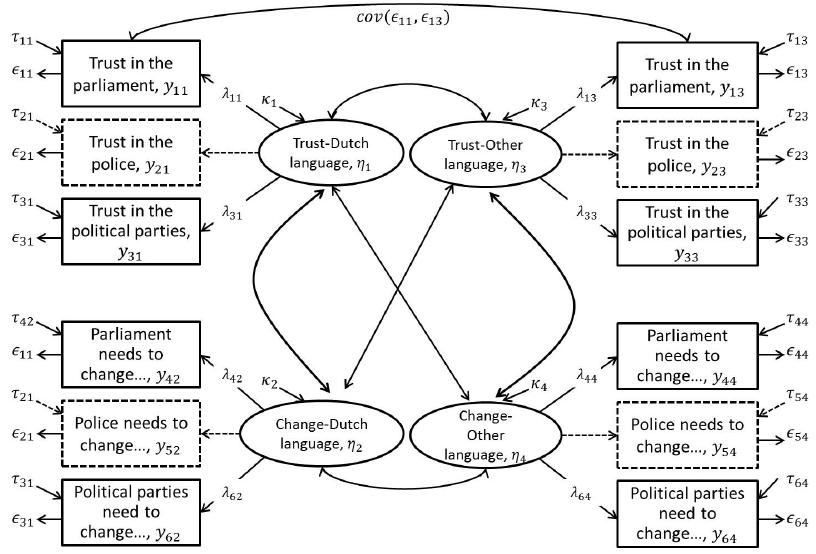
Figure 1 Model 1: Trust and need of change in institutions